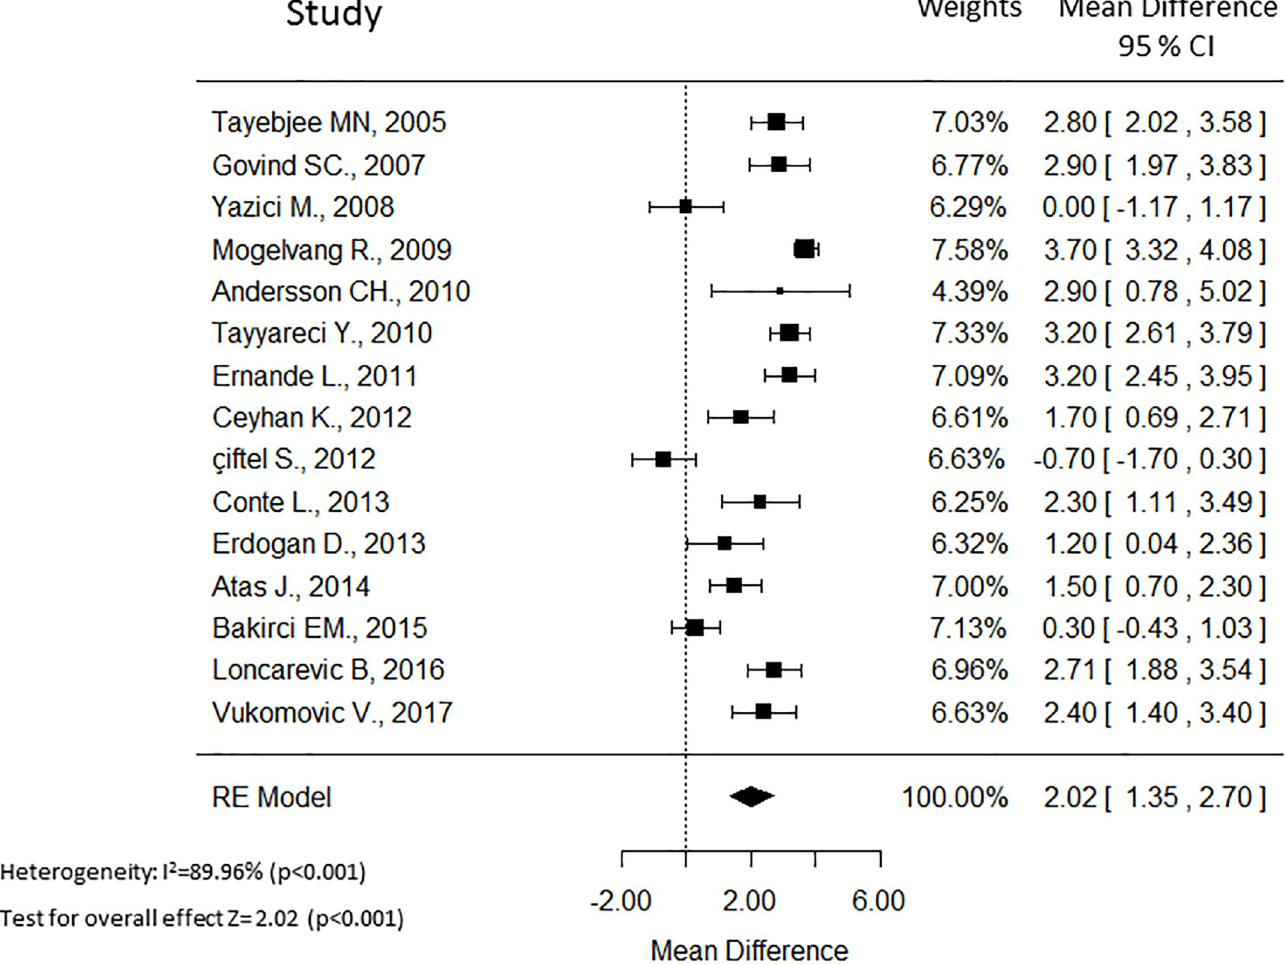
PLOS ONE | https://doi.org/10.1371/journal.pone.0209794 December27,